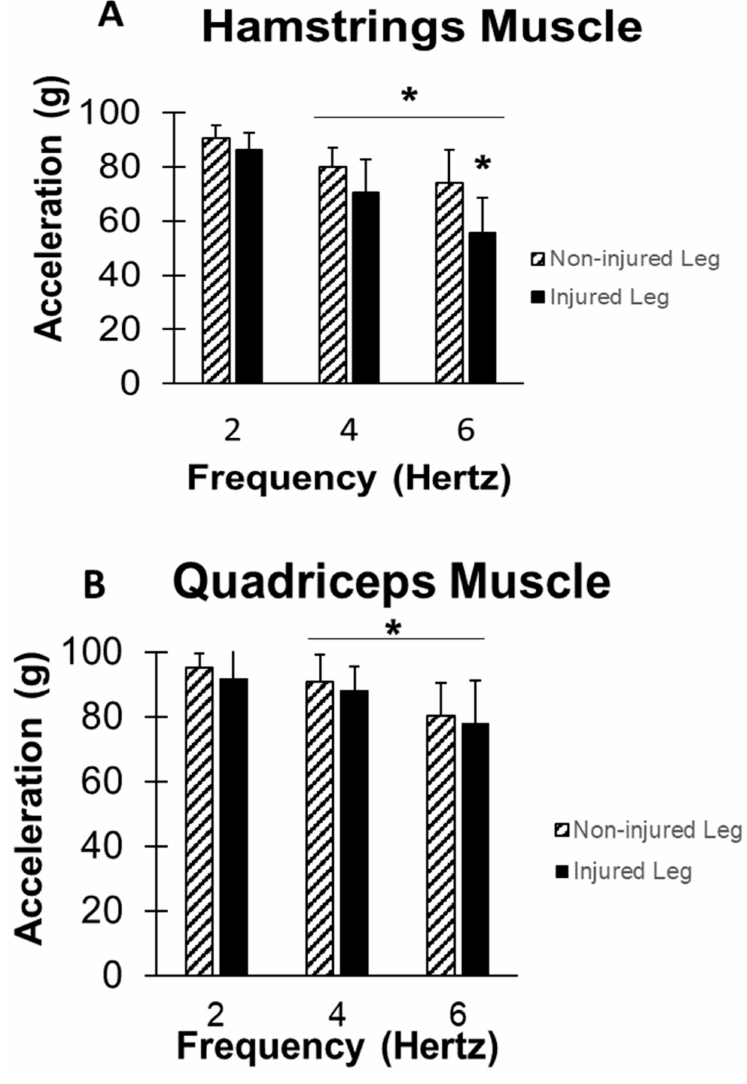
Figure 2. ( A ) Mean and standard deviation of the endurance index for the hamstrings muscle at three frequencies (2 Hz, 4 Hz, and 6 Hz) for each leg. ( B ) Mean and standard deviation of the endurance index of the quadriceps muscle at three frequencies (2 Hz, 4 Hz, and 6 Hz) for each leg. * represents significant difference ( p <